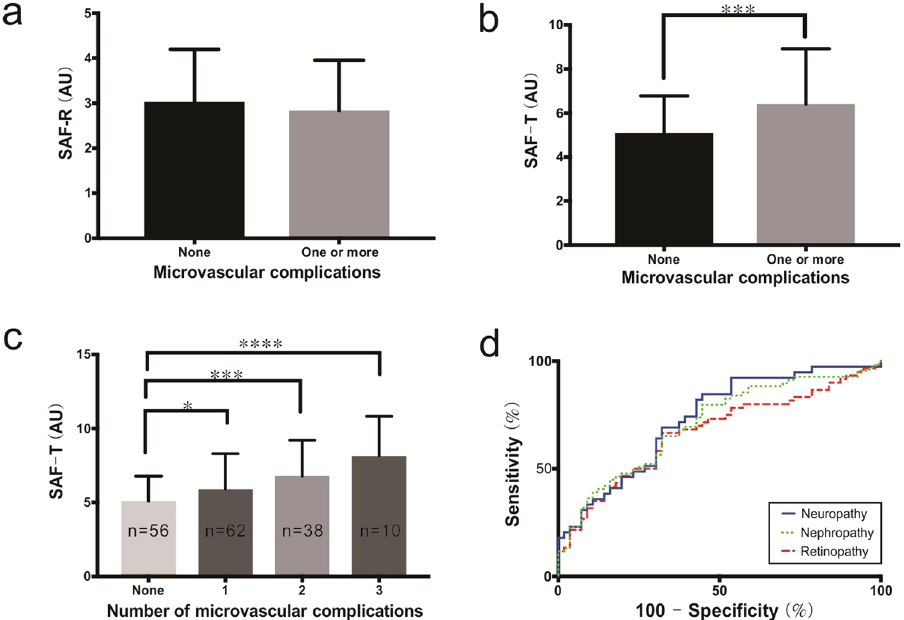
Figure 2. SAF and Microvascular Complications. ( a ) Statistical comparison of reflected SAF values on the volar side of the forearms (SAF-R) between a complication group and a non-complication group. ( b ) Statistical comparison of transmitted SAF values in the 1st dorsal interossei muscles of the hand (SAF-T) between a complication group and a non-complication group. ( c ) SAF-T values with respect to the number of microvascular complications. ( d ) SAF-T utilized receiver operating characteristic curves regarding different microvascular complications. Error bars represent standard deviation. (Asterisks * , ** , *** , and **** indicate p < 0.05, p < 0.01, p < 0.001, and p < 0.0001,